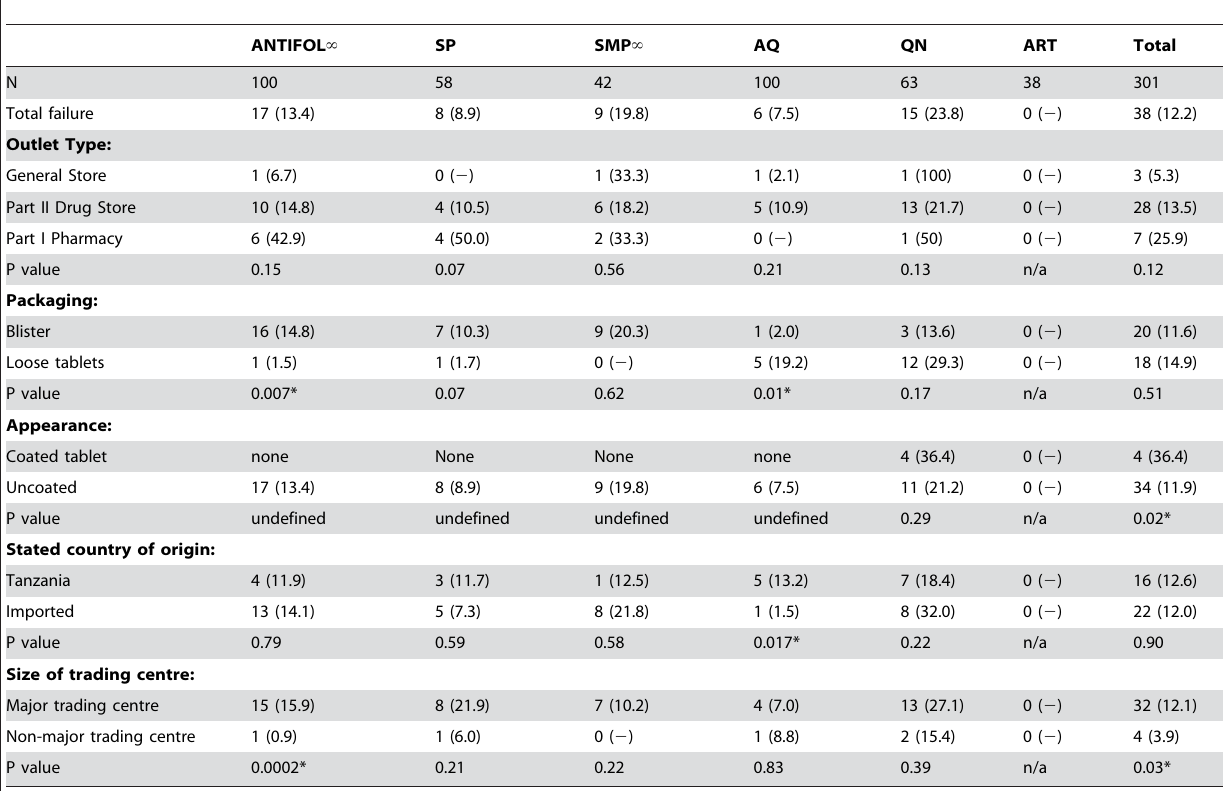
Table 4. Numbers and adjusted percentage of samples not meeting the USP tolerance limits for quality test by active ingredient and potential risk